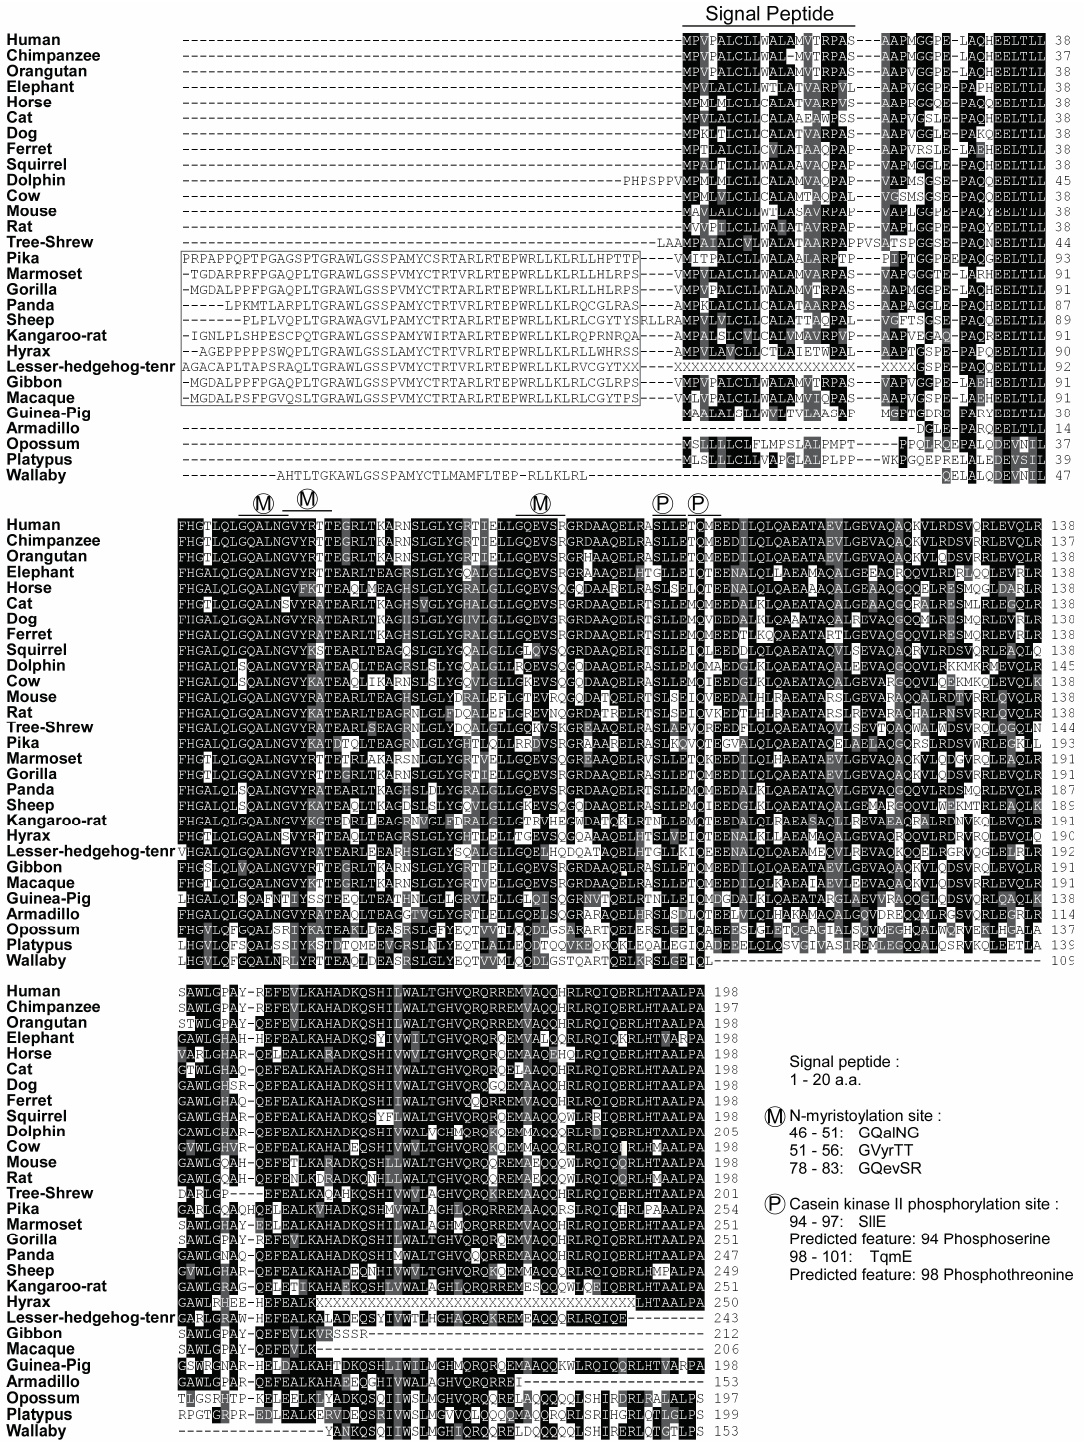
Figure 2. Sequence alignment of betatrophin orthologs in mammals. Amino acid sequences alignment of identified betatrophin orthologs (sequences in black color, identical; grey color, similar). Two suborders, megabat and microbat, are not included for their divergent sequence and thermogenesis regulation. The putative signal peptide and protein modification sites (M; N -myristoylation, P; casein kinase phosphorylation, estimated using Pro-site) are indicated. The extra N -terminal sequences which conserved in several species are also highlight (from Pika to Macaque, 10